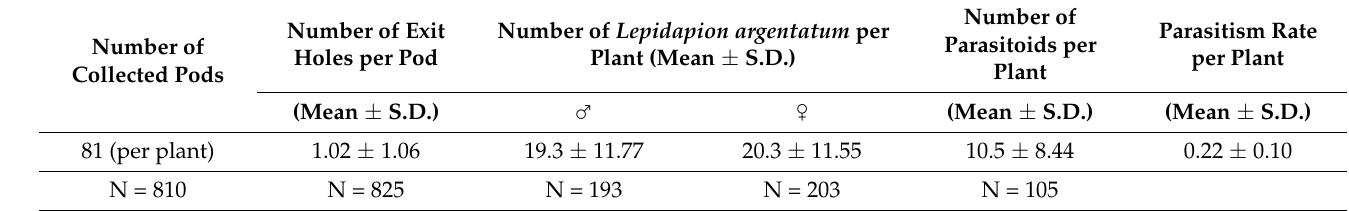
Figure 2. Dissection of a Genista monspessulana (Fabaceae) pod containing, viable, aborted and consumed seeds by Lepidapion argentatum (Coleoptera, Brentidae). Table 1. Results of Lepidapion argentatum adult and parasitoids emergence from randomly collected pods from 10 Genista monspessulana plants at St Gilles (France) in 2015.